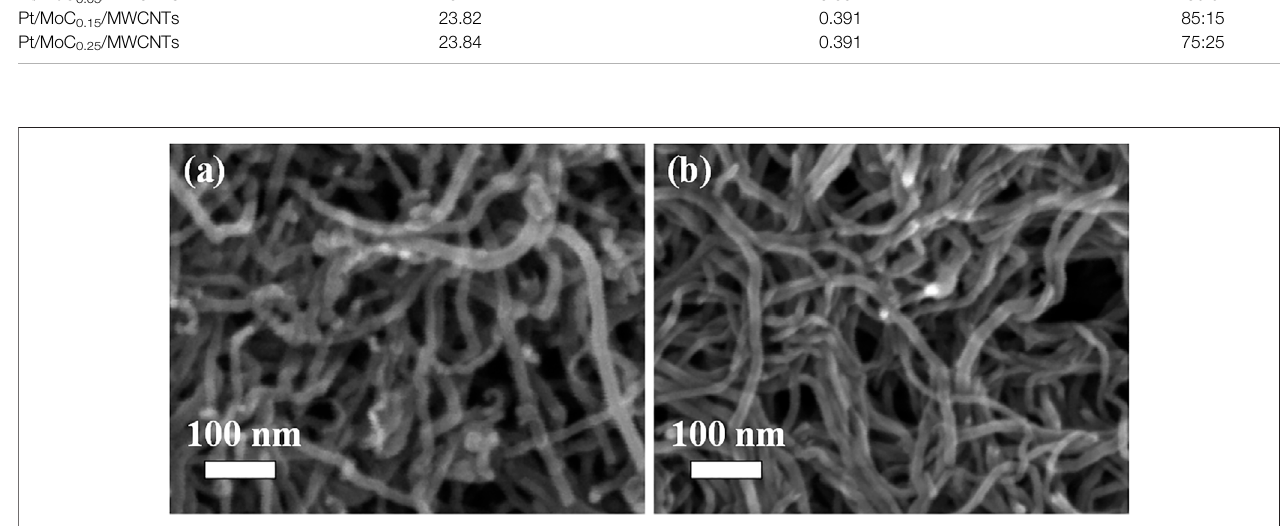
FIGURE 3 | FESEM images of (A) MWCNTs and (B) acid-treated MWCNTs.